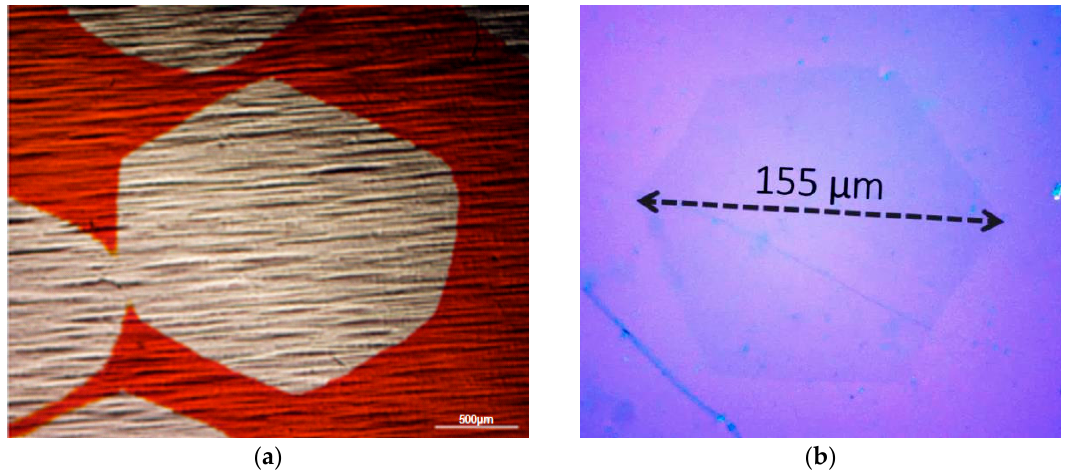
Figure 15. Optical micrograph of ( a ) an individual domain of mm sized CVD grown single layer graphene on Cu and ( b ) bilayer graphene on SiO 2 /Si substrates.